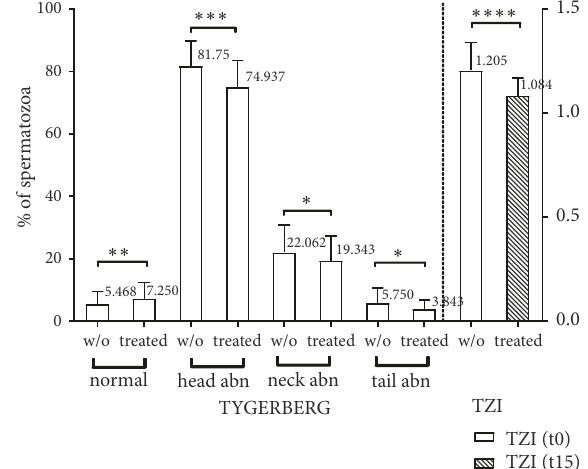
Figure 6: Fifteen-minute incubation with DNase I streamlines spermatozoa morphology and TZI of high viscosity semen. w/o: semen without treatment, treated: semen treated with DNase I, head abn: head abnormalities, tail abn: tail abnormalities, and TZI: teratozoospermia